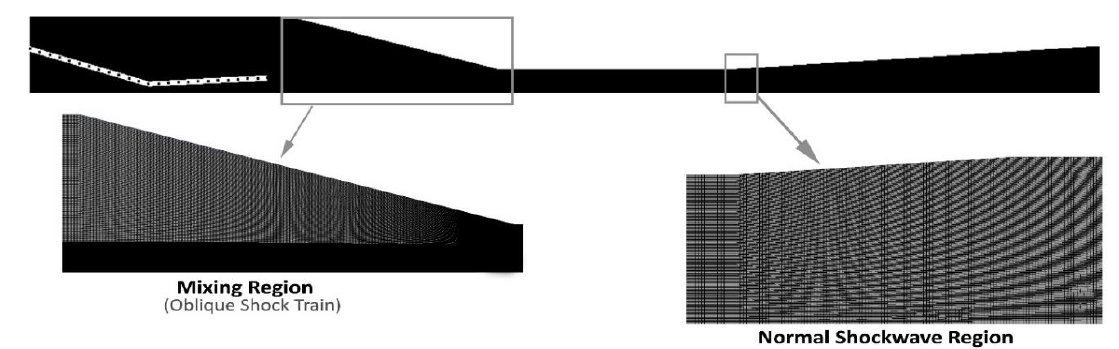
Figure 7. Final mesh with magnified regions (to shown refined mesh at critical flow locations).